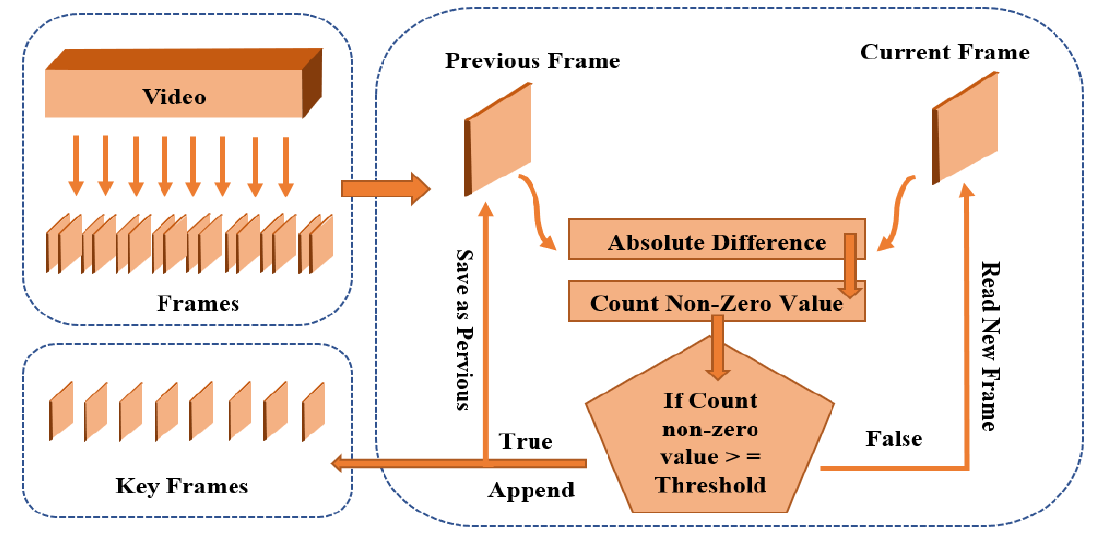
Figure 4. Flow Diagram of Key Frame Extraction Technique. Algorithm 1: Key-Frame Extraction [29]